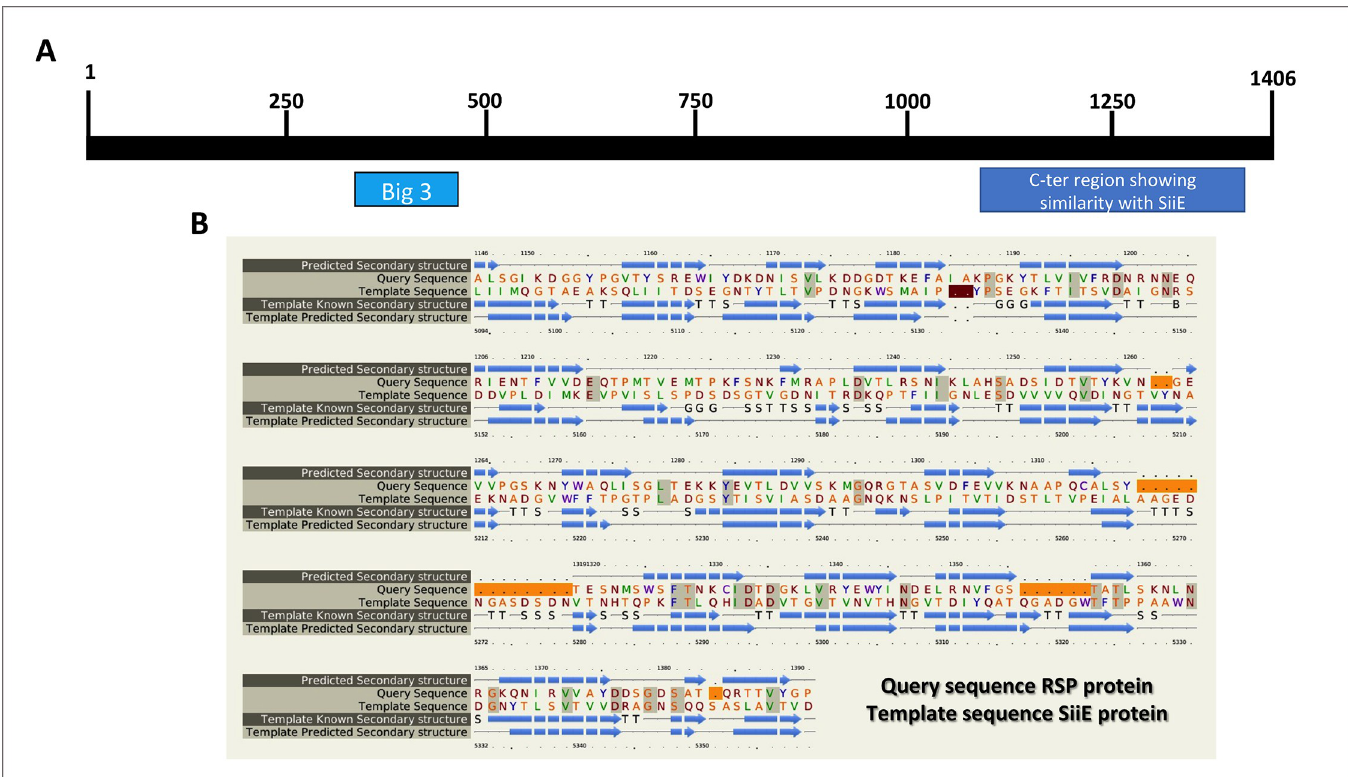
Fig 1. Diagram representing the RSP protein (A) and the alignment of the C-terminal region from the RSP protein that shows similarity to the SiiE protein from Salmonella Thyphimurium (B). A) The putative bacterial Ig-like domain (Big 3) that maps between the 331 and 470 amino acid residues was identified using the Conserved Domain algorithm (https://www.ncbi.nlm.nih.gov/cdd/) and the C-terminal region identified using Phyre2 program that shows similarity to SiiE are shown. B) Alignment of the C-terminal region encompassing amino acids 1146 to 1391 from the RSP protein that shows similarity to the SiiE protein from Salmonella Thyphimurium. The alignment was generated using the Phyre2 program. The query sequence is the RSP protein, and the template sequence is the SiiE protein, as indicated in the